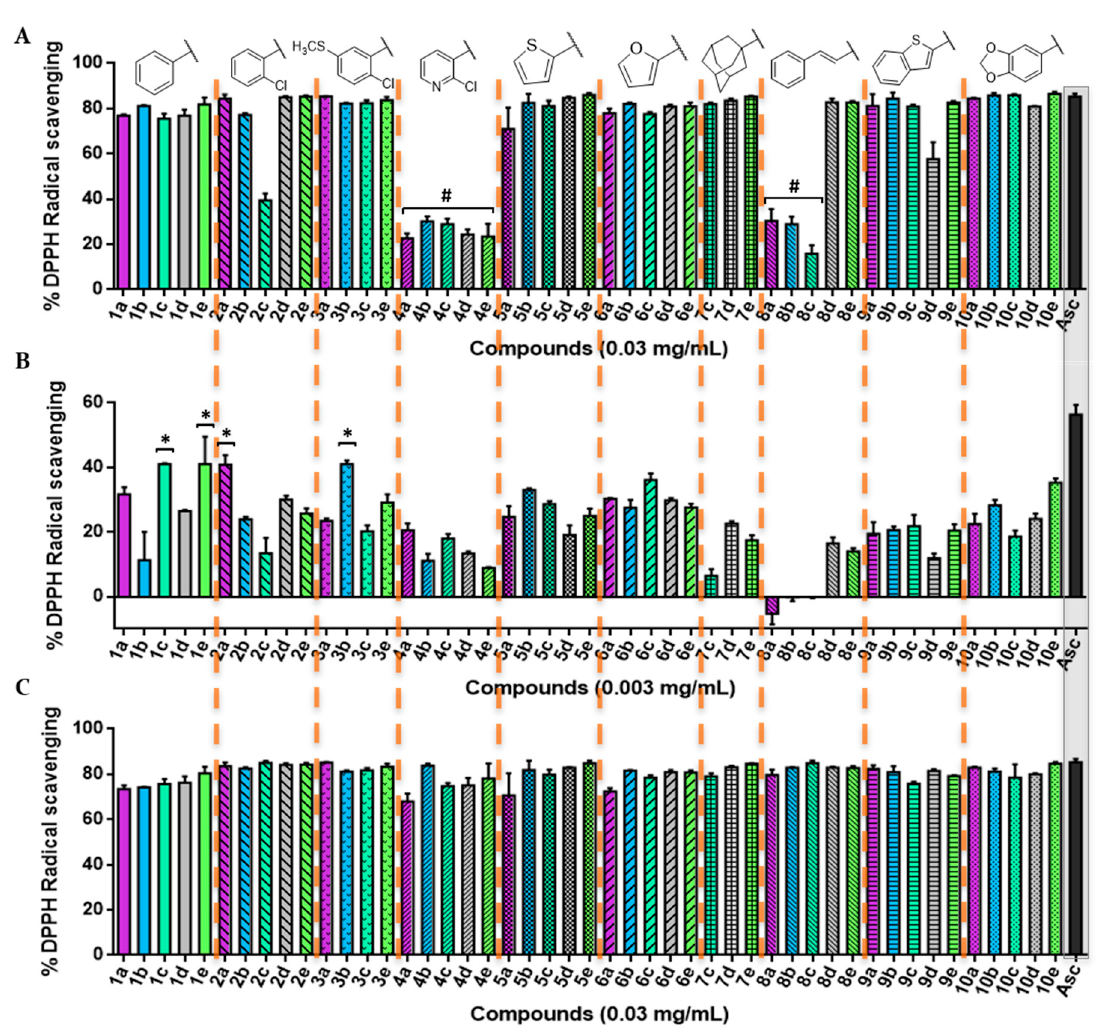
Figure 3. 2,2-diphenyl-1-picrylhydrazyl (DPPH) radical scavenging activity of the novel compounds synthetized in this work. ( A ) Percentage of DPPH • scavenging after 0 min at the highest concentration tested (0.03 mg / mL); ( B ) percentage of DPPH • scavenging after 0 min at 0.003 mg / mL; ( C ) percentage of DPPH • scavenging at 0.03 mg / mL after 30 min for all of the 47 compounds. Significance: * p < 0.05 compared with ascorbic acid (Asc). The results obtained for lower concentrations and longer times are included in the Supplementary Material.